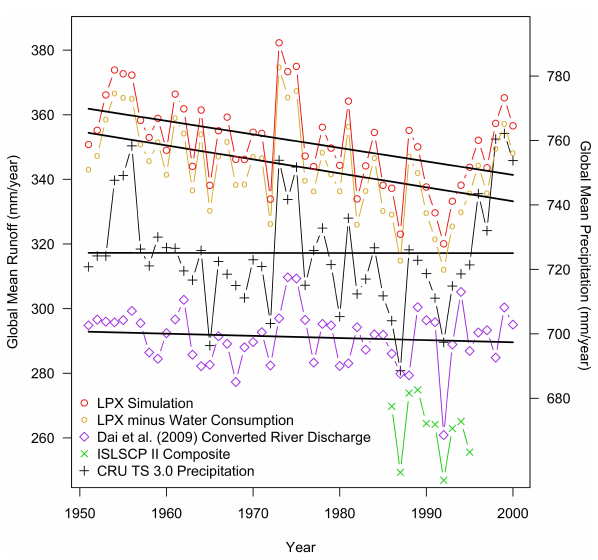
Fig. 1. Global Mean Annual Runoff as simulated by LPX for 1951– 2000 (and also with WaterGAP freshwater consumption incorpo- rated), compared to ISLSCP II composite runoff dataset for 1986– 1995, Dai et al. (2009) converted river discharge observations and CRU global mean annual